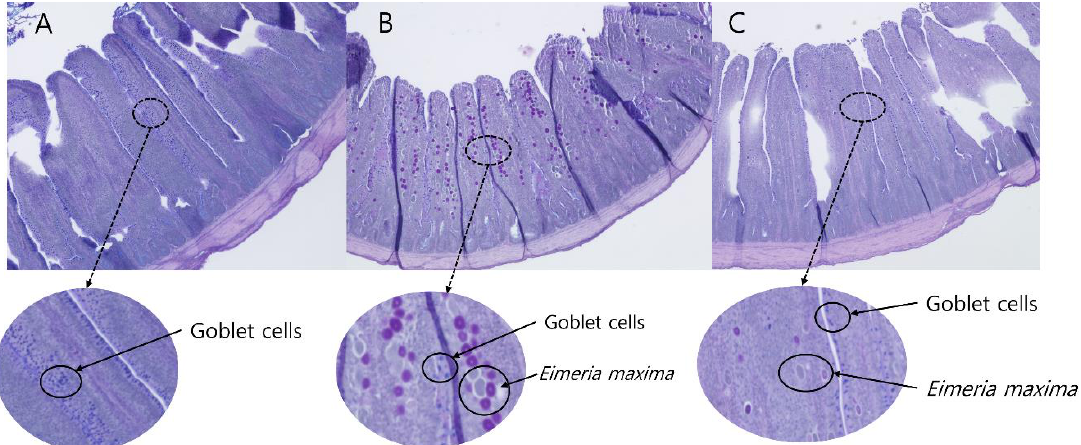
Figure 1. Alcian blue/the period acid-Schiff (AB/PAS)-stained jejunal morphology of ( A ) SCC (sham-challenged control): chickens fed a control diet and challenged with phosphate-buffered saline; ( B ) CC (challenged control): chickens fed a control diet and challenged with 10 4 of Eimeria maxima ; and ( C ) TA0.5 (tannic acid 500 mg/kg): CC + 500 mg/kg tannic acid. Small purple dots are goblet cells, and big white and purple dots are E. maxima . The SCC group had no E. maxima